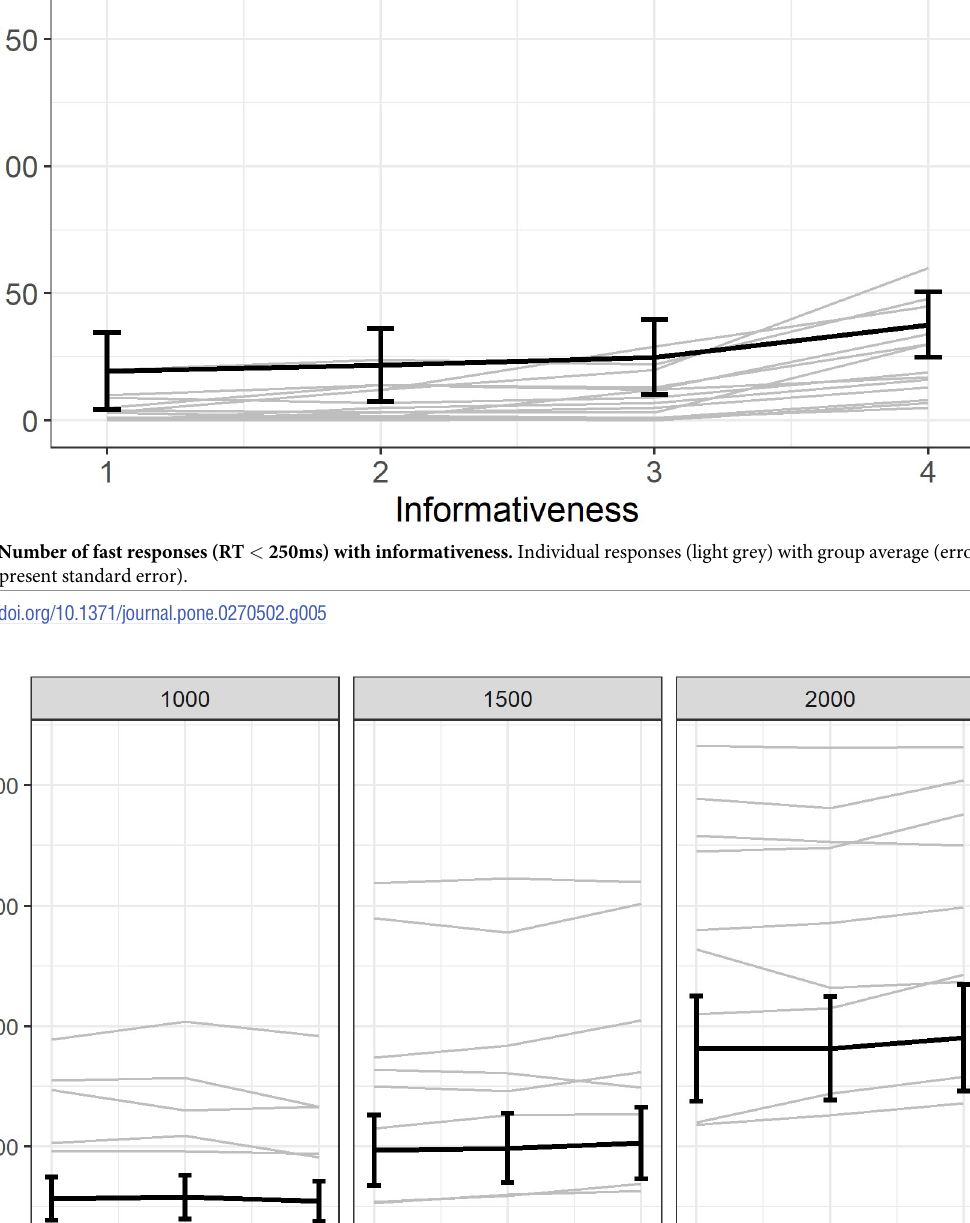
PLOS ONE | https://doi.org/10.1371/journal.pone.0270502 July 5,